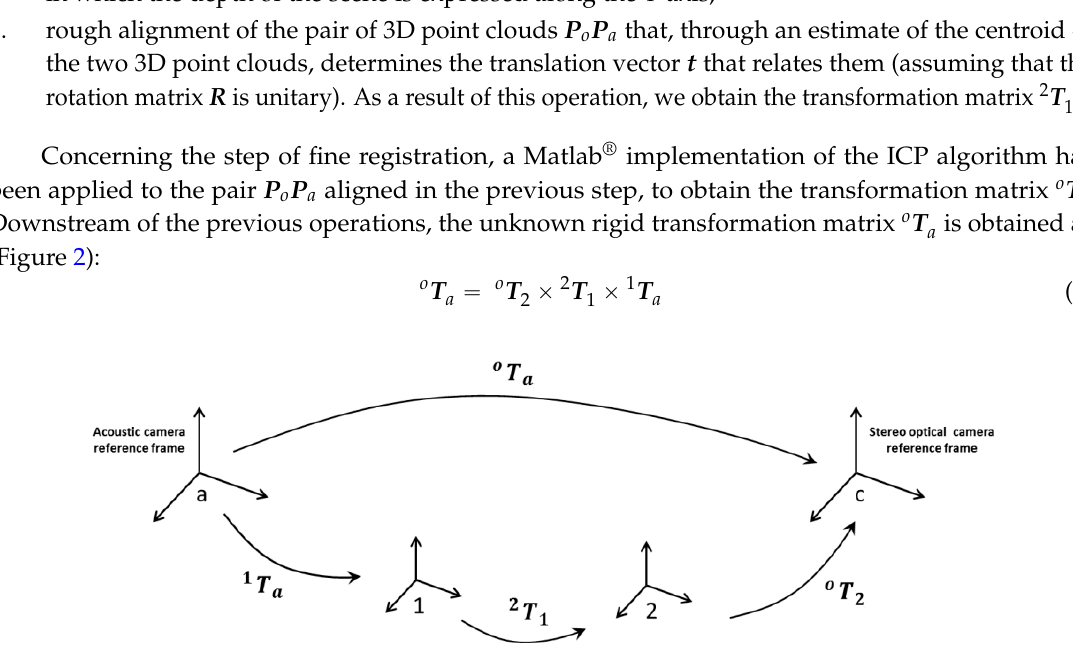
Figure 2. Sequence of transformations for computing the (cid:2176) (cid:3042) (cid:3028) matrix.